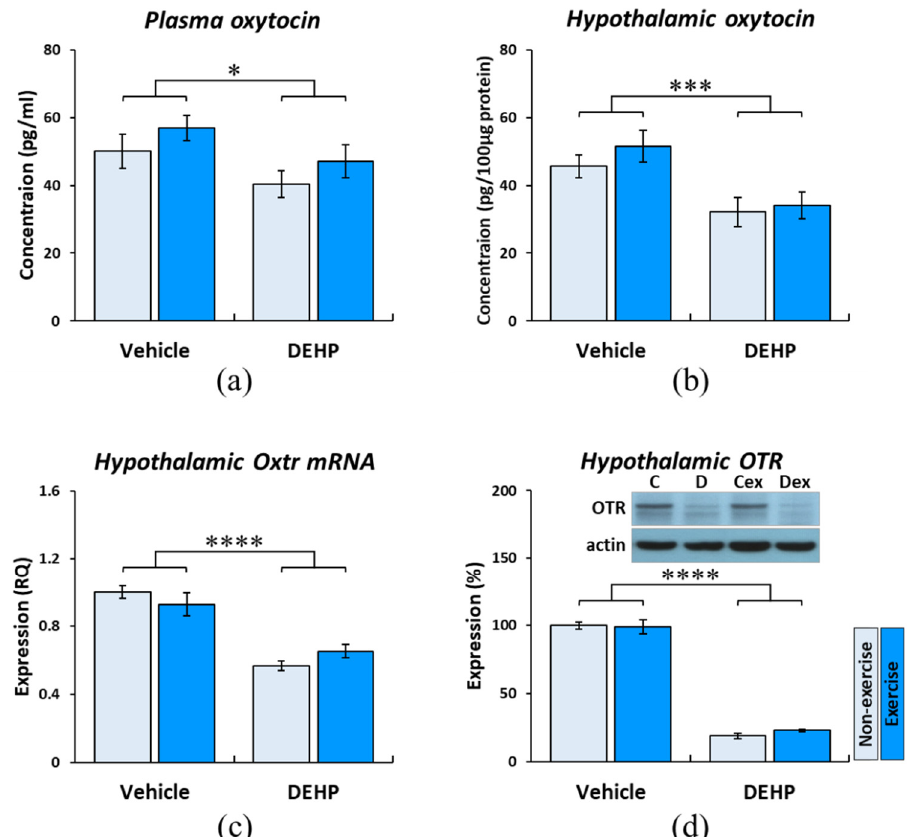
Figure 2. Effects of prenatal DEHP exposure and childhood exercise on the oxytocin pathway in postpartum dams. The results of ELISA showed that oxytocin levels in the plasma ( a ) and hypothalamus ( b ) were reduced by the effect of DEHP. ( c ) The result of qPCR showed a reduction of hypothalamic Oxtr mRNA influenced by the effect of DEHP exposure. ( d ) The result of the Western blot showed there was a significant effect of DEHP on reducing the hypothalamic OTR levels. Data are presented in mean ± SEM ( n = 12 per group for plasma; n = 6 per group for hypothalamus). *: p < 0.05; ***: p < 0.005; ****: p < 0.001.